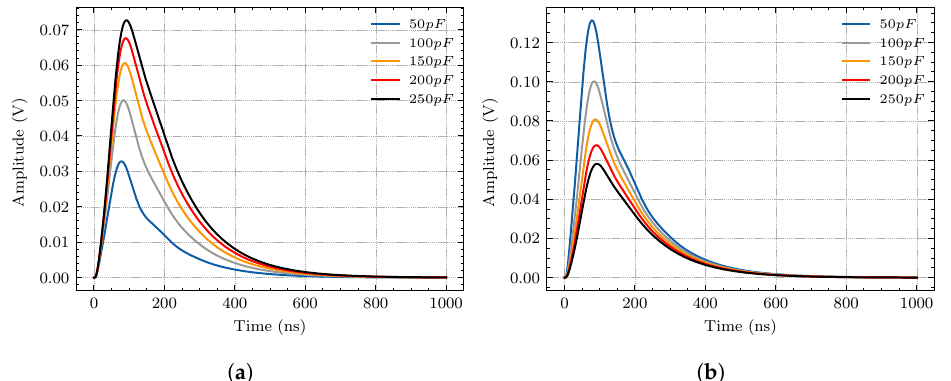
Figure 6. Sensor responses of different capacitances. ( a ) Mutual capacitance C 1 is positively correlated with sensor response. ( b ) Self-capacitance C 2 is negatively correlated with sensor